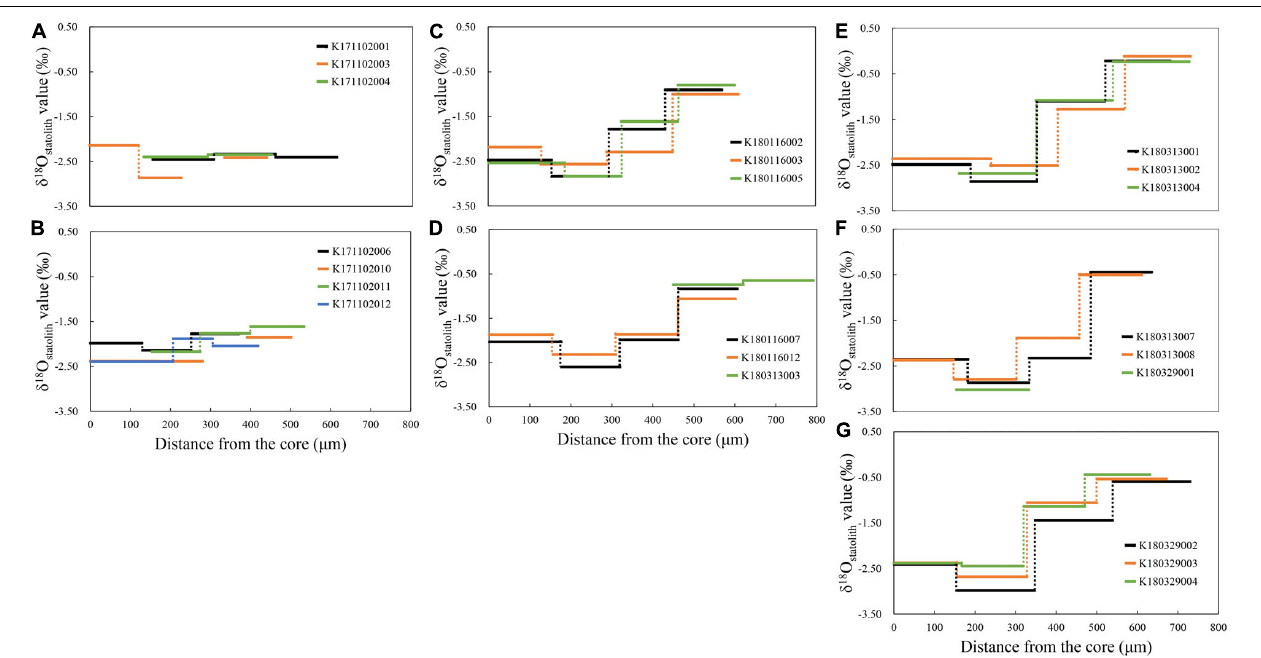
FIGURE 5 | δ 18 O statolith profiles of S. lessoniana from the statolith core to the edge of each individual in the spring group (A,B) , summer group (C,D) , and autumn group (E–G)